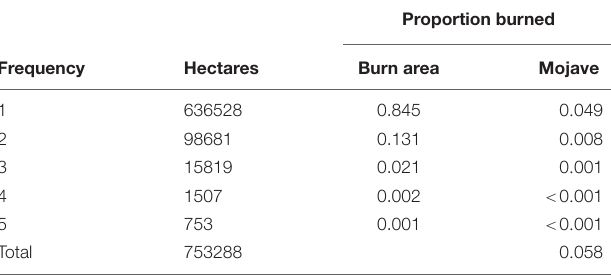
TABLE 2 | The number and proportion of hectares burned in fires > 405 ha in the Mojave Desert of North America, 1972 –